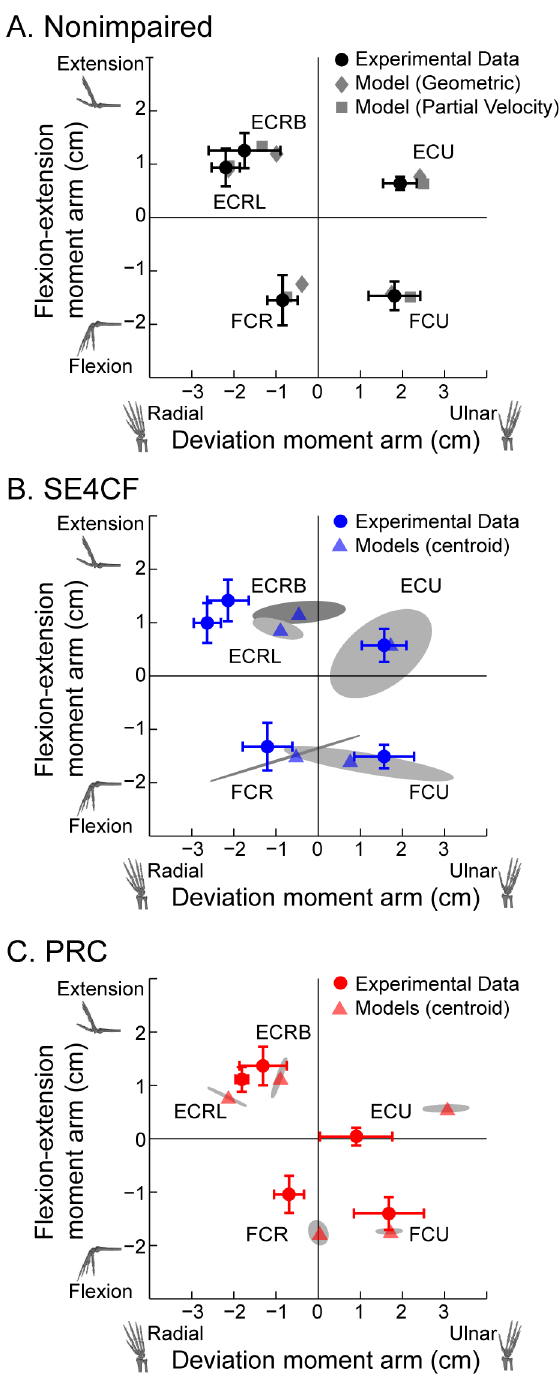
Fig 7. Model Predicted and Experimentally Measured Moment Arm Comparison. Comparison of moment arms predicted by the models (non-circular shapes) to moment arms measured in the experiment (filled circles) for the (A) nonimpaired, (B) SE4CF, and (C) PRC wrists. In each graph, flexion-extension moment arms are plotted as a function of radial-ulnar deviation moment arms. Error bars represent one standard deviation. In (B) and (C), the model data (triangles) represent the centroid of the moment arms predicted by the surgical models, and the shaded regions are the minimum area ellipses that enclose the predicted values, thereby representing the spread of the model predictions. All values are moment arms at a neutral wrist